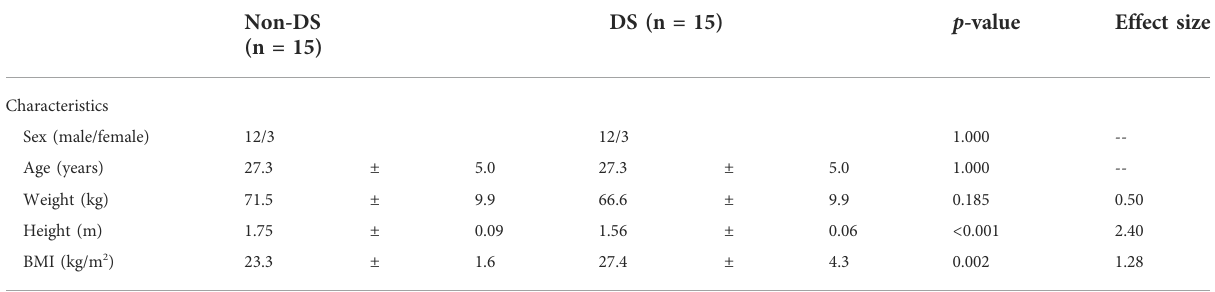
TABLE 1 Participants ’ characteristics.